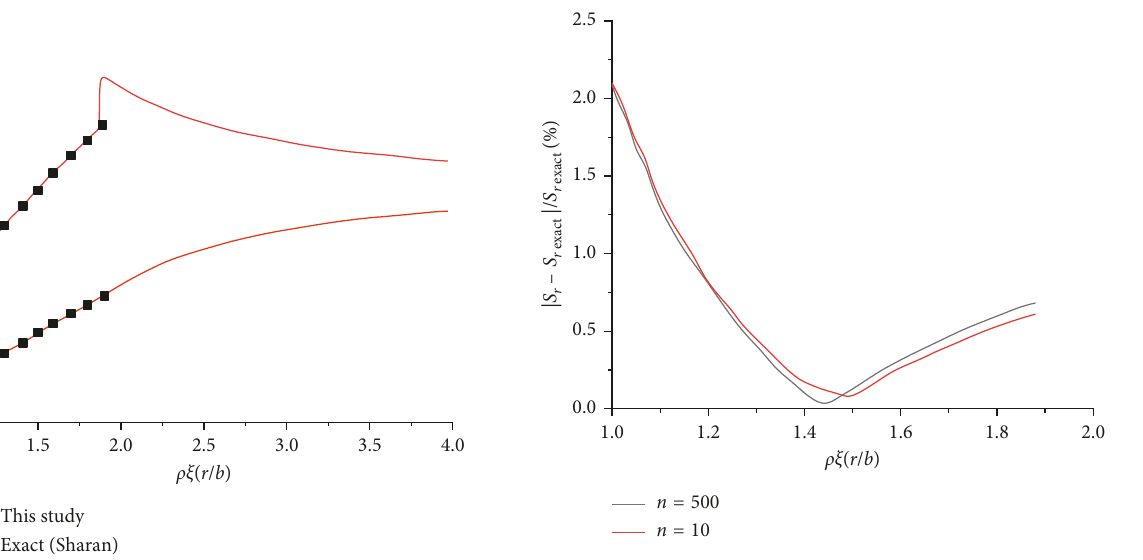
Figure 4: Comparison between dimensionless stresses and exact stresses for Hoek–Brown rock mass.